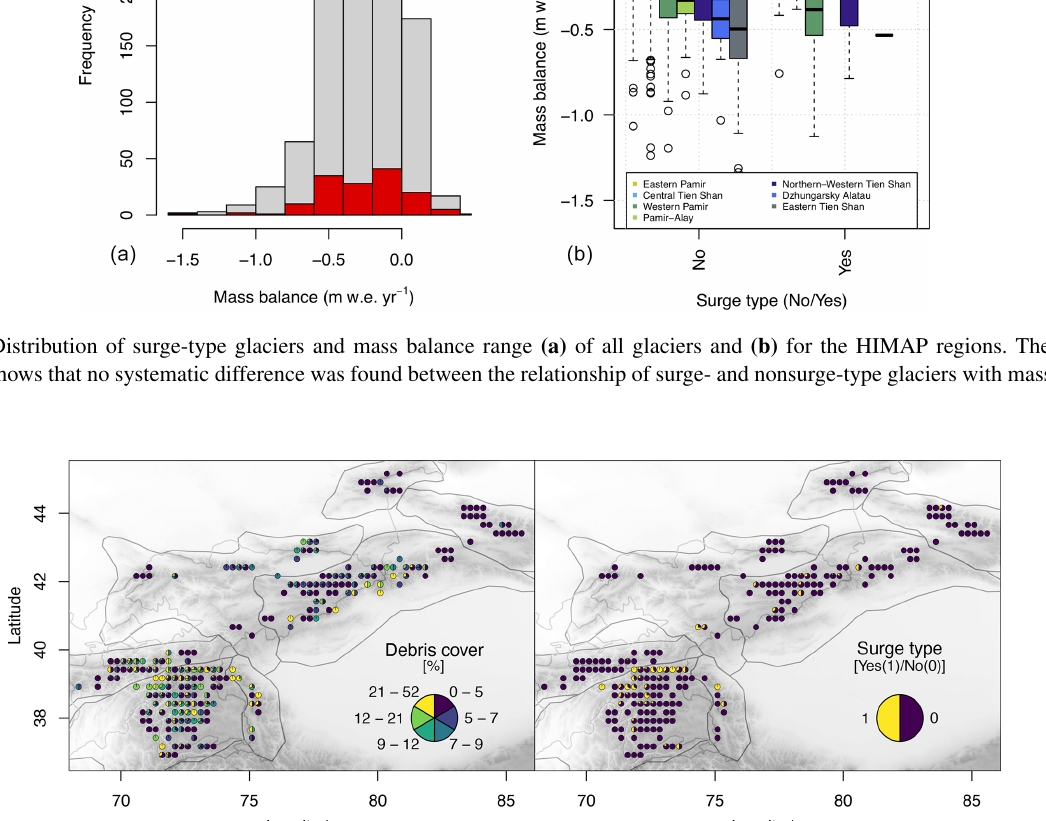
The Cryosphere, 17, 1343–1371, 2023